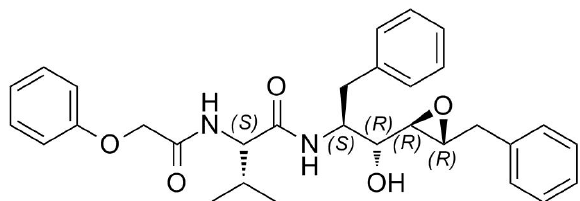
Figure 1. Structure of EPX inhibitor, (C 31 H 36 N 2 O 5 ). MW = 516.63 g/mol.